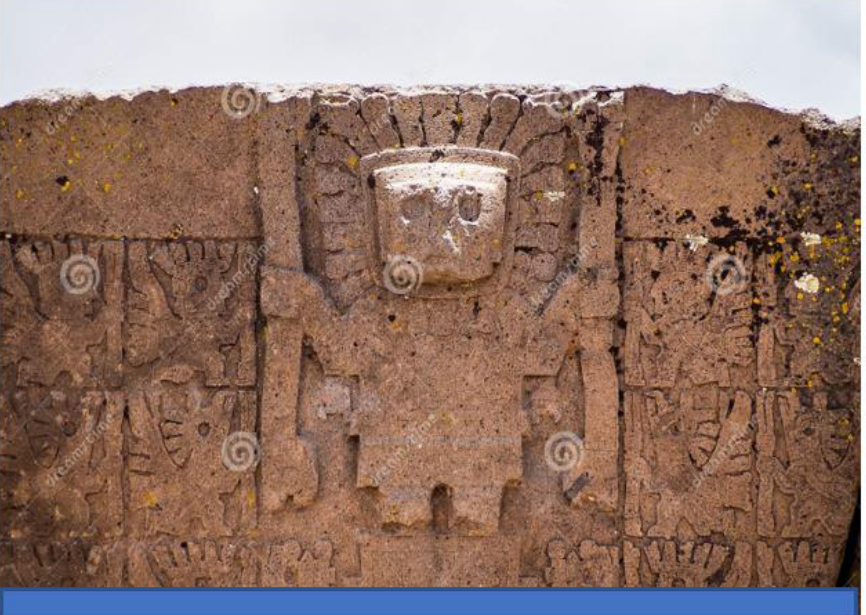
Figure 42. Gateway of the Sun deity iconography; site located in central urban Tiwanaku. Photo by